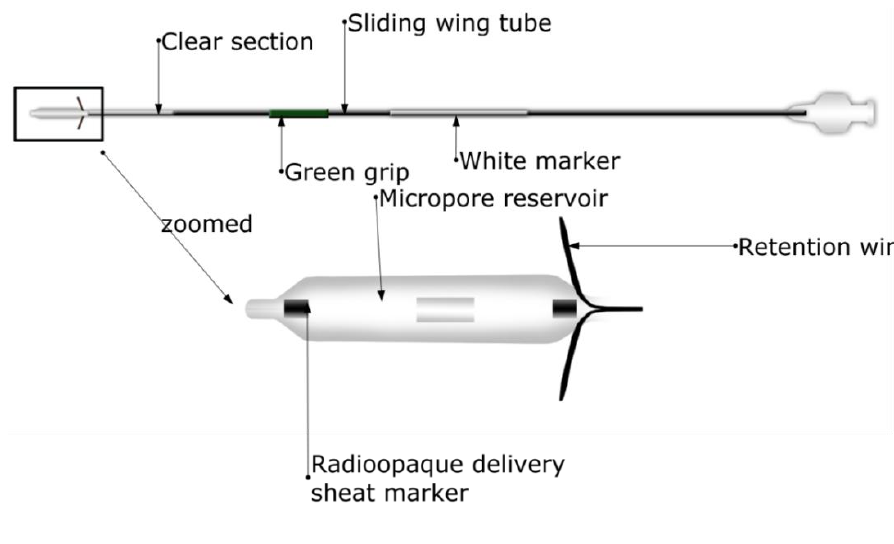
Figure 6. A typical design of a Relieva Stratus™ Microflow spacer, which contains a microporous reservoir, thus slowly releasing the drug to promote the wound healing of chronic ethmoid sinus mucosal